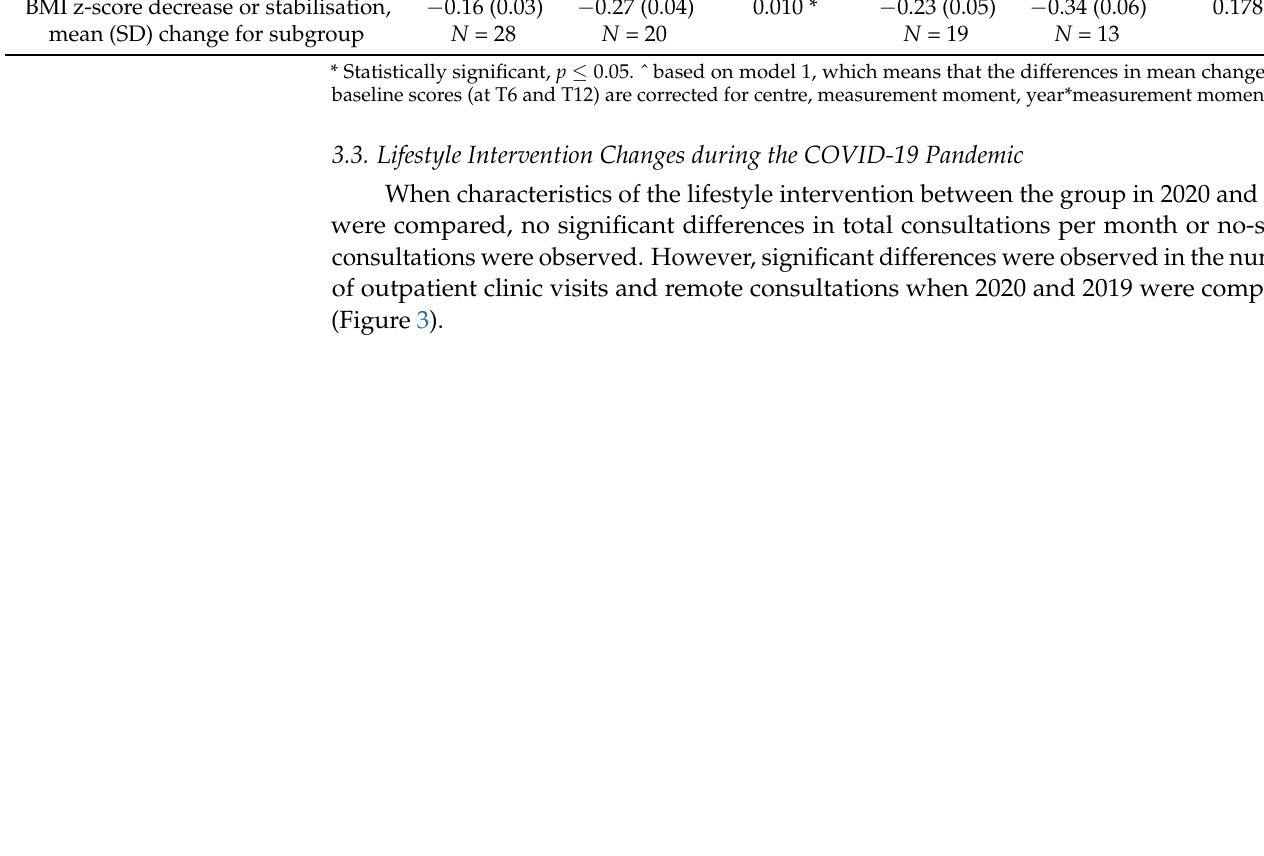
Table 2. Mean change for subgroups that had an increase or decrease/stabilisation in the BMI z- score at T6 and T12 in 2020, when compared to 2019.